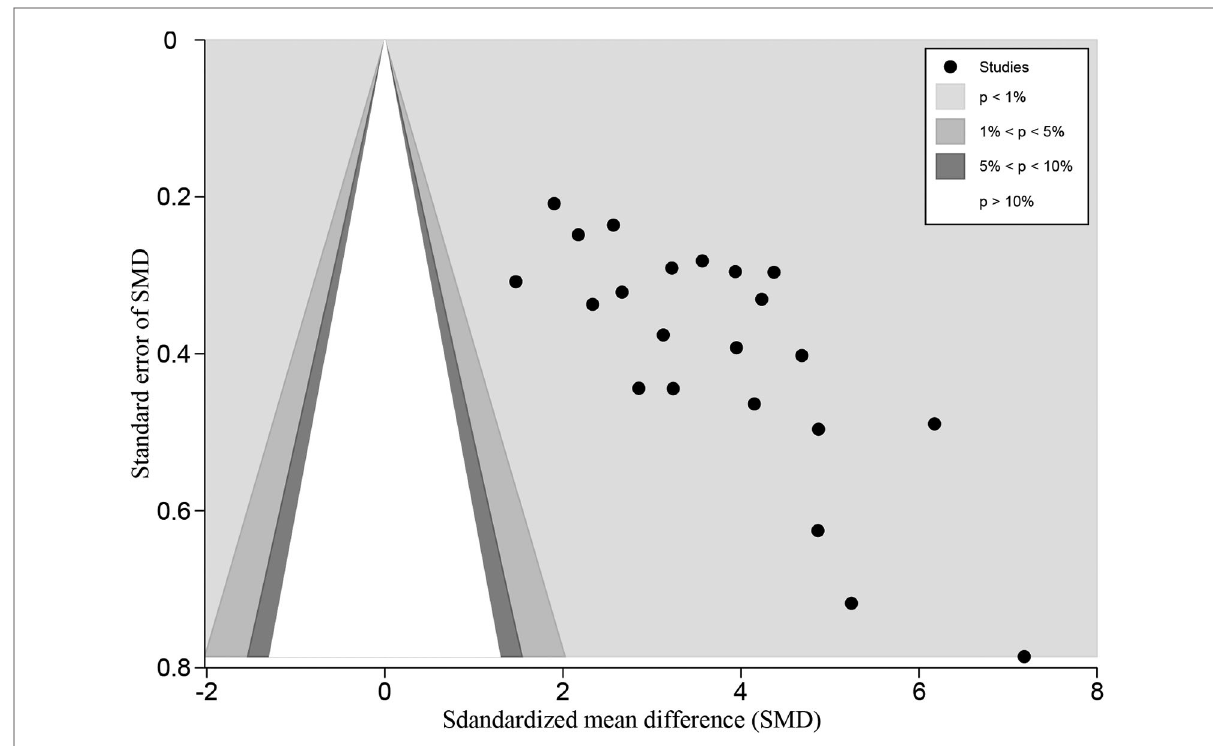
FIGURE 5 Confunnel plot for HHS comparison between posttreatment and pretreatment. HHS, harris hip